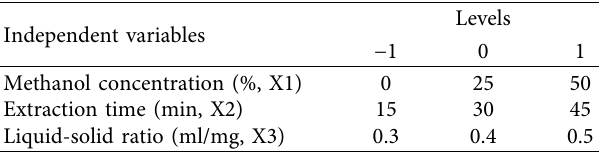
Table 1: Comprehensive evaluation for the extracts in single-factor